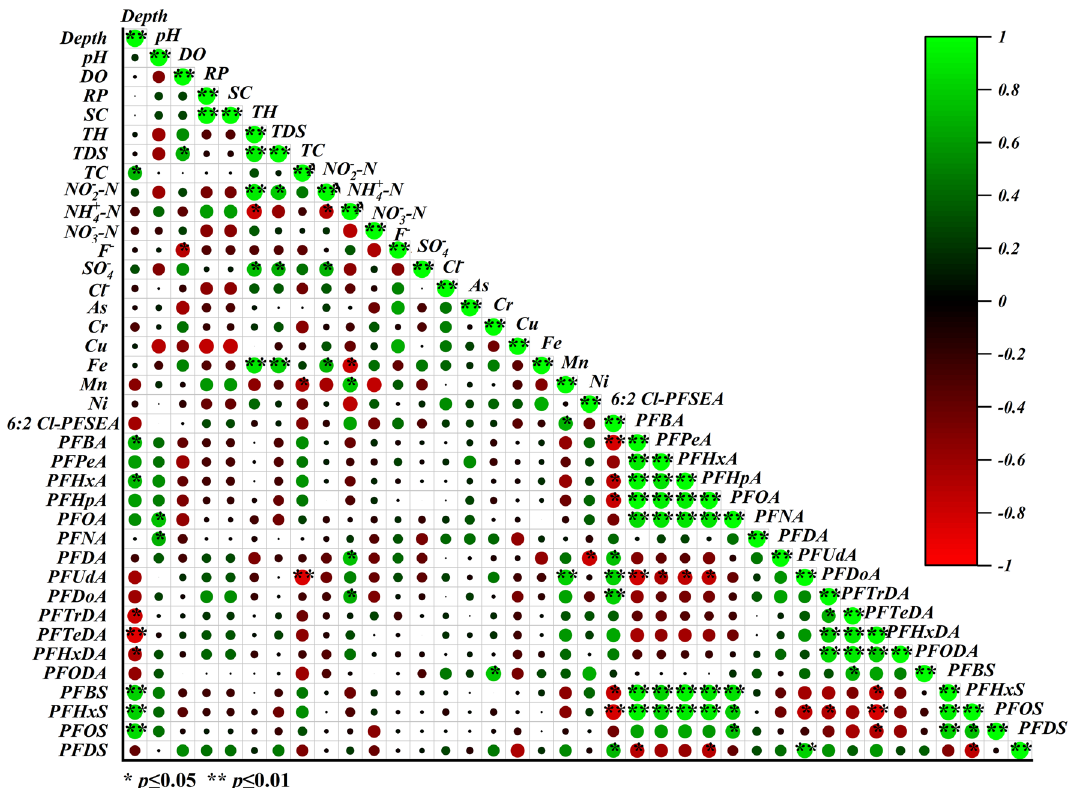
Figure 2. Correlations between physicochemical properties and multiple pollutants in groundwater from the FCP of Fuxin City, Liaoning